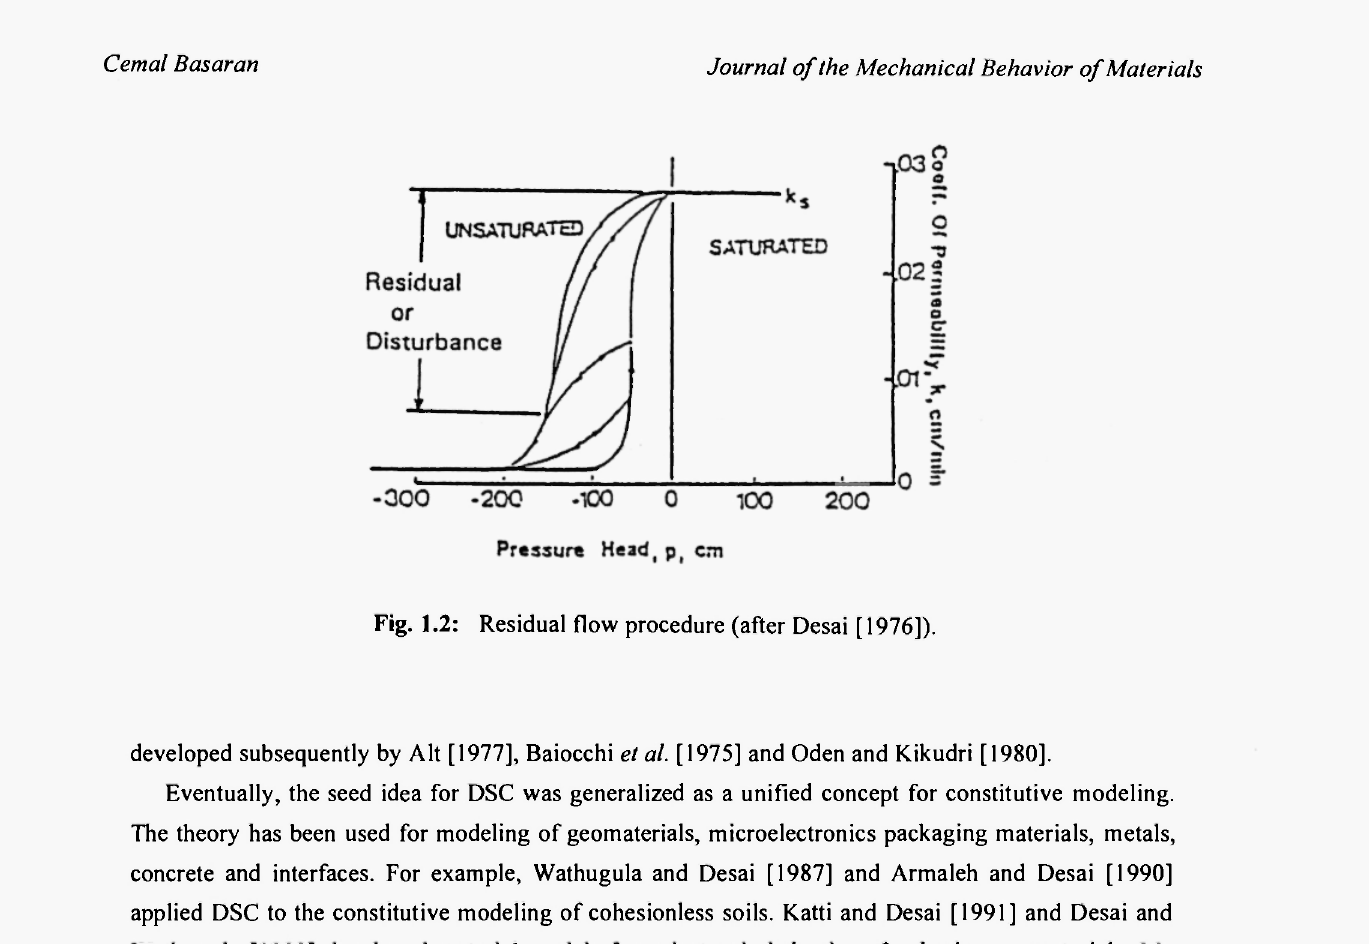
Fig. 1 .2: Residual flow procedure (after Desai